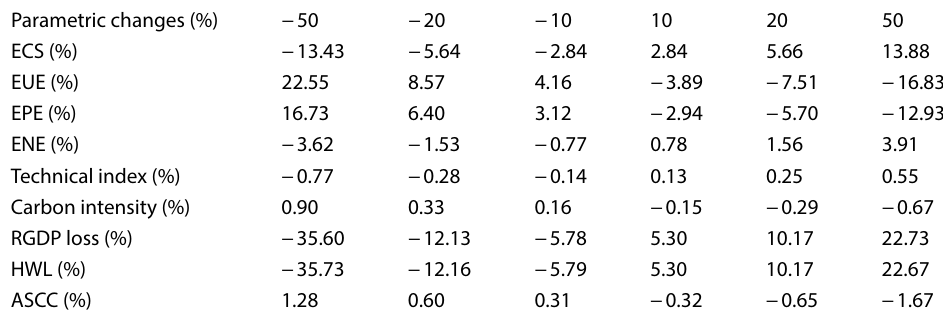
Table 8 The results of the sensitivity analysis in 2015 at the 1%